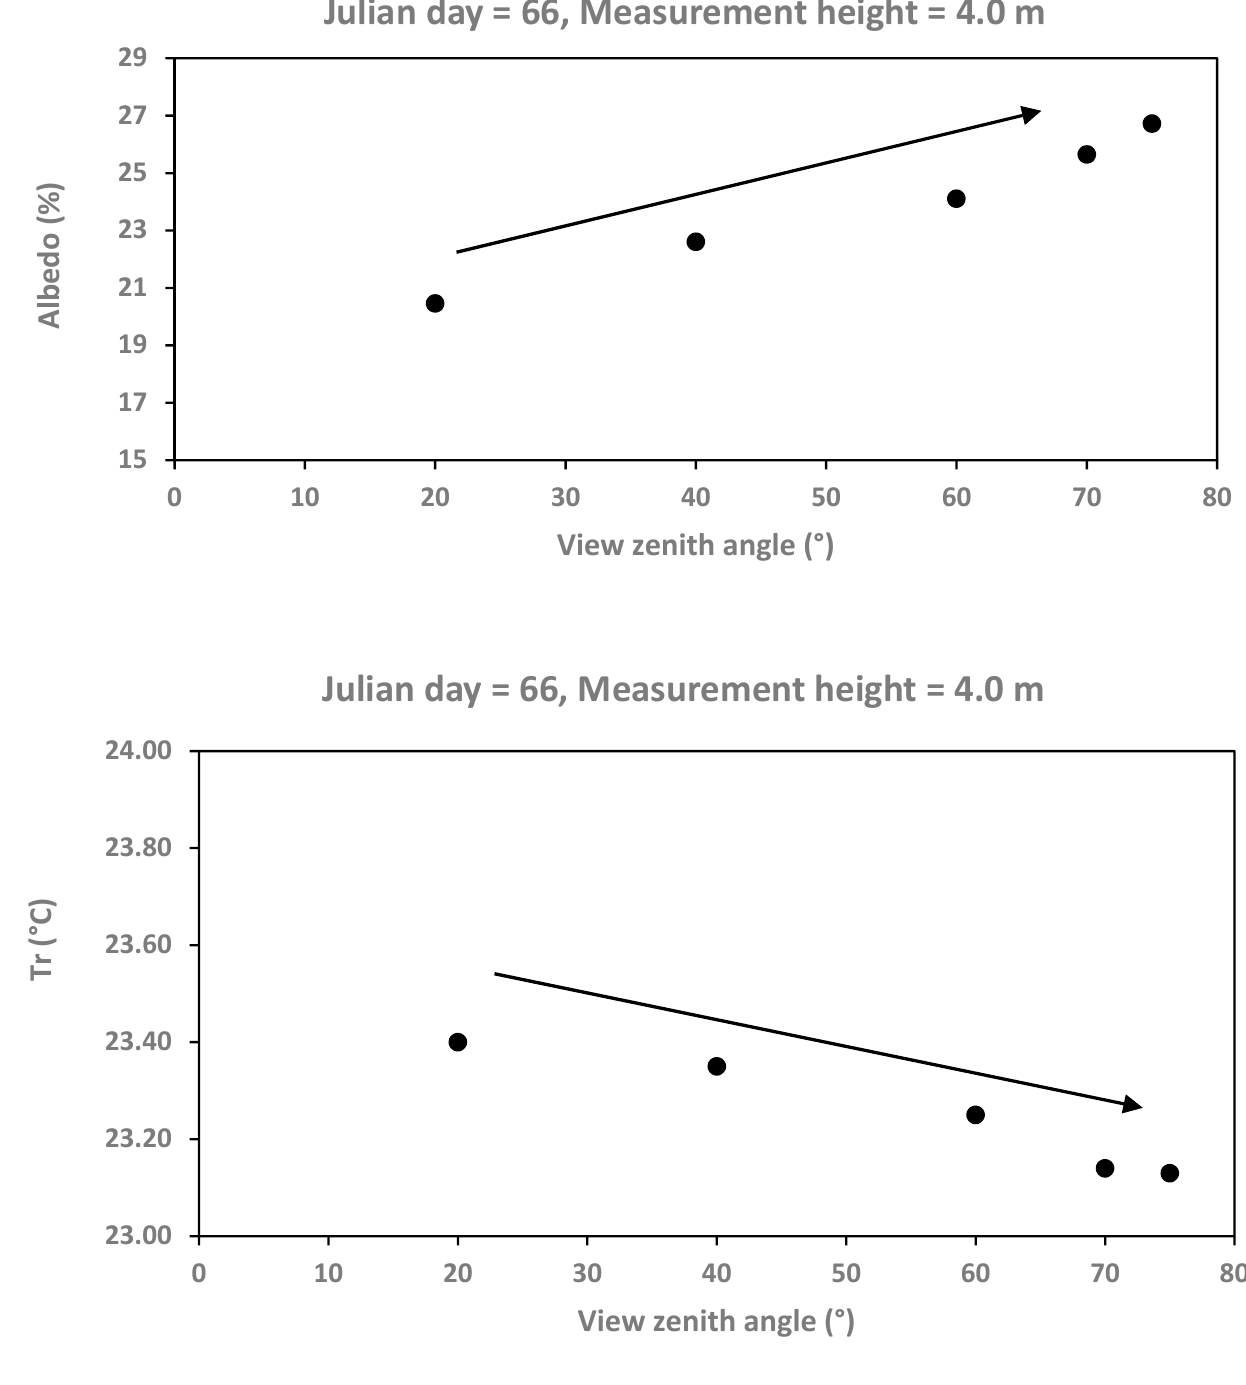
Figure 11. Variation of albedo and radiative measurements for chickpea (PH4) for Julian day 66. Finally, two conditions (fv = 0 and maximum fv) were considered for the analysis of Rn patterns with solar illumination (solar zenith angle variation). The patterns are shown in Figure 12 for chickpea crop (PH4). The maximum value of Rn was around solar moon and it decreased in the morning and afternoon (solar zenith angles were higher than the solar